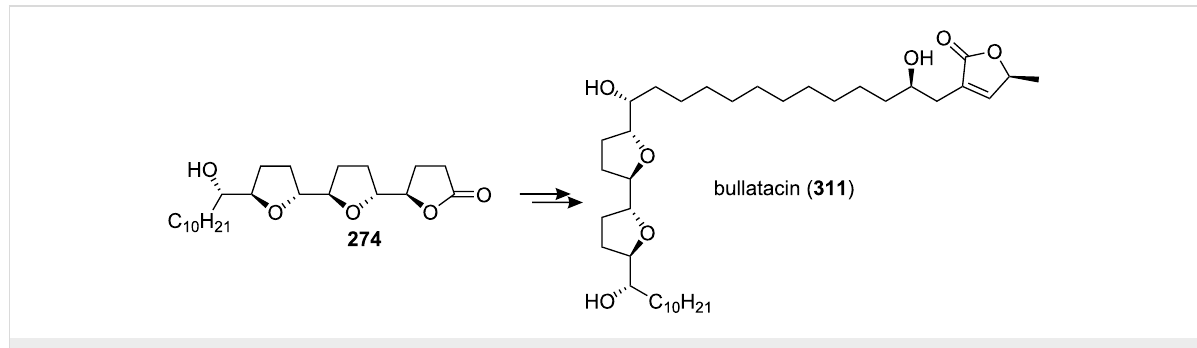
Scheme 42: Total synthesis of bullatacin by the group of Sinha and Keinan.